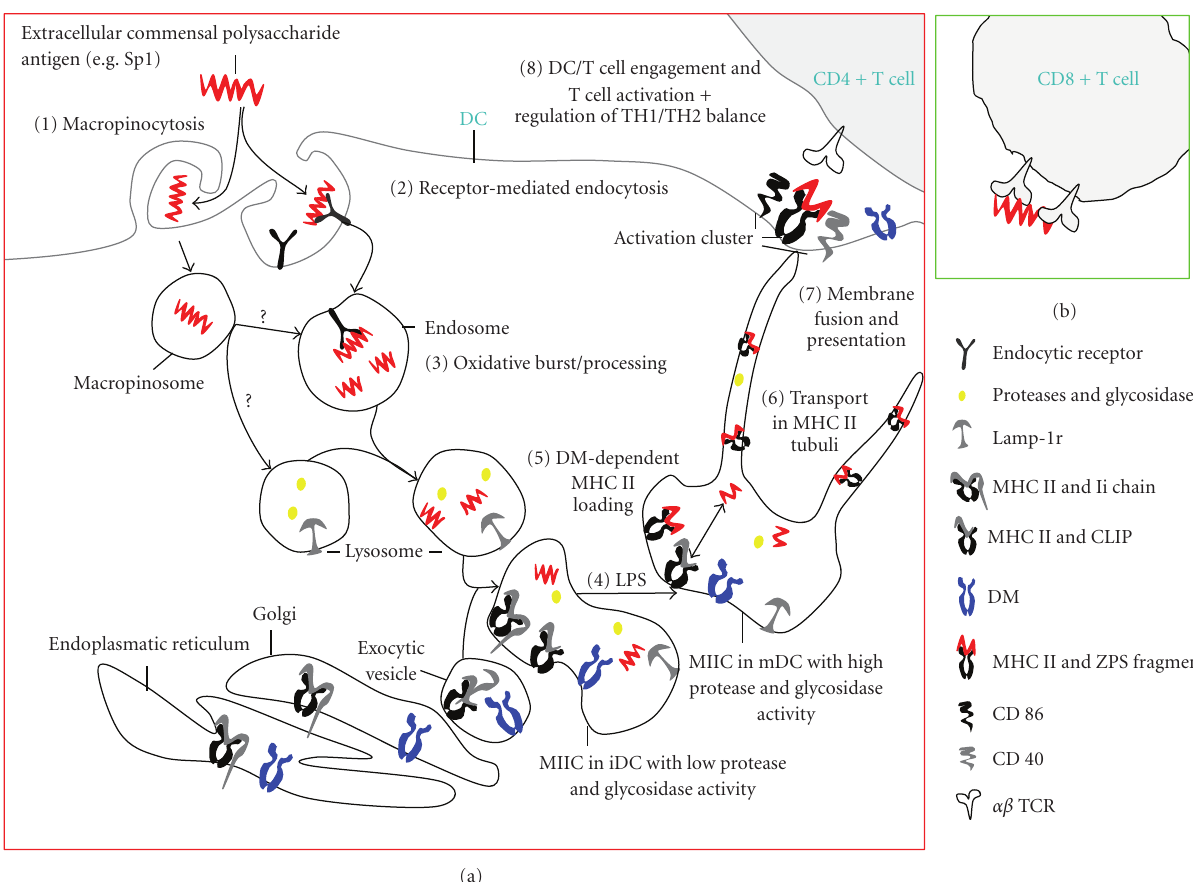
Figure 2: (a) Schematic model illustrating the key steps in the presentation pathway of ZPS antigens in DCs. (1) ZPS antigensare internalized by macropinocytosis through PI3-kinase-dependent mechanism and (2) receptor-mediated endocytosis. (3) In early endosomes, DCs potentially undergo an oxidative burst, including the production of nitric oxide (NO) to process the antigen to lower molecular weight (MW) polysaccharides. ZPS-containing early endosomes fuse with late endosomes and then with lysosomes. Macropinosomes fuse with endosomes or lysosomes. (4) The MHCII protein with Ii chain and the DM molecule are assembled in the endoplasmatic reticulum (ER), transported through the Golgi apparatus, and then budded into exocytic vesicles. ZPS-rich endo/lysosomes fuse with exocytic vesicles, creating a MIIC vesicle carrying MHCII, DM, LAMP-1, proteases, and glycosidases. (5) LPS triggers maturation of iDCs with an increased Ii cleavage to CLIP, DM, and MHCII-antigen-binding activity, and protease and glycosidase activity, which possibly process ZPS to fragments of di ff erent lower molecular sizes. DM catalyses antigen exchange of CLIP and other self-peptides with ZPS. ZPS is loaded onto MHCII. (6) ZPS/MHCII complexes are shuttled in tubules originating from lysosomes to the cell surface for (7) fusion with the cell membrane and presentation on the cell surface. (8) Presentation of MHCII/ZPS and costimulatory CD40 and CD86 signals induce DC/T cell engagement and immune responses of CD4 T cells in vitro and in vivo through the αβ TCR. (b) ZPS activation of CD8 T cells by just crosslinking the surface TCRs without MHCI-mediated